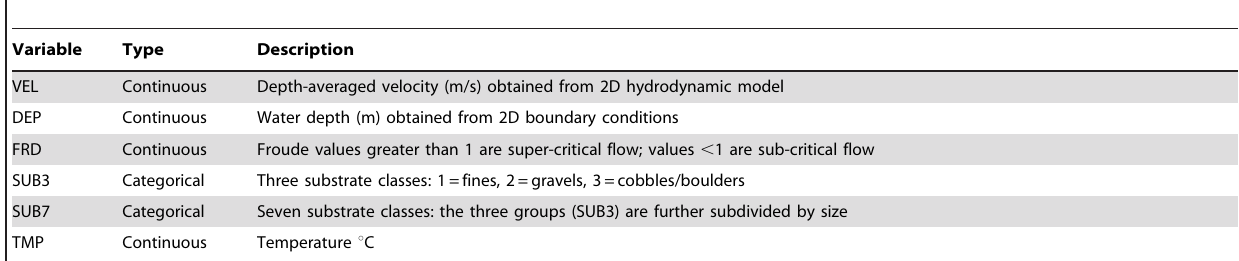
Table 1. Predictor variables used for Moapa dace habitat